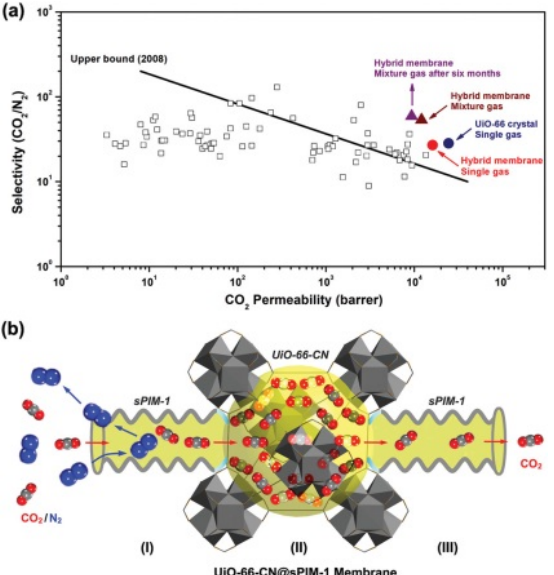
Figure 22. A graphic illustration of CO 2 and N 2 mixture gas across the UiO-66-CN@sPIM-1 membrane. ( a ) A summary of MOF-based hybrid membranes reported up to date for the application in CO 2 / N 2 separation ( b ) a schematic illustration of CO 2 and N 2 transport across the UiO-66-CN@sPIM-1 membrane. Reprinted with permission from [222], Copyright (2019) John Wiley and Sons publications.